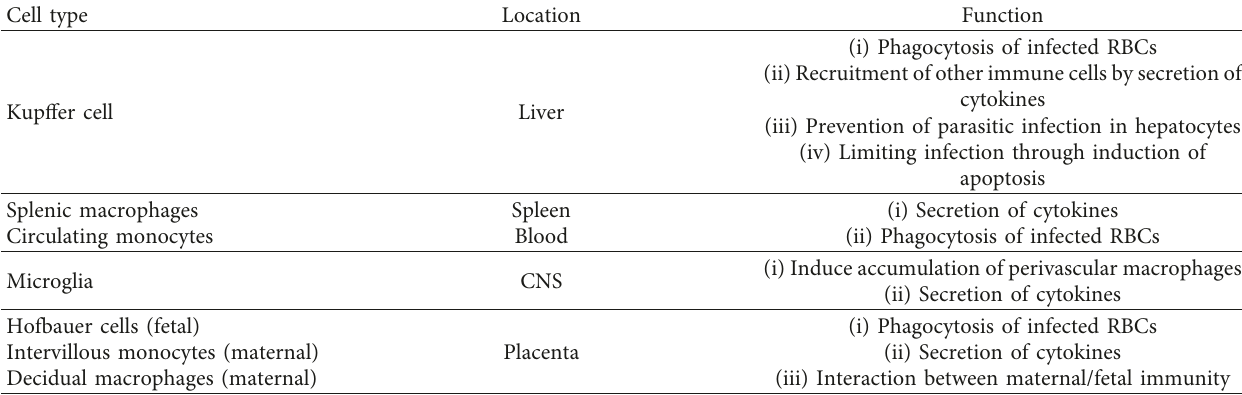
Table 1: Diverse cell types mediate malaria-induced immune response and